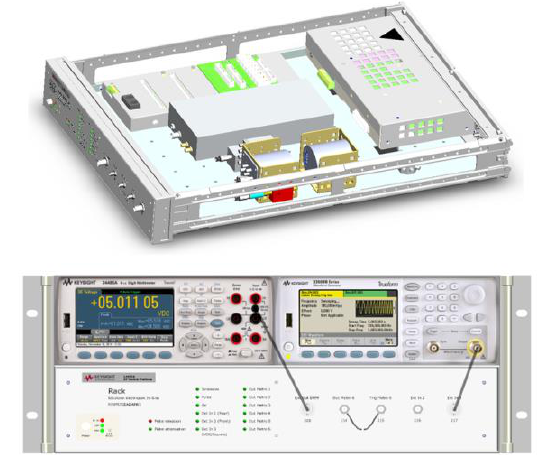
Fig. 4. Customized rack designed to realize in situ metrological measurements